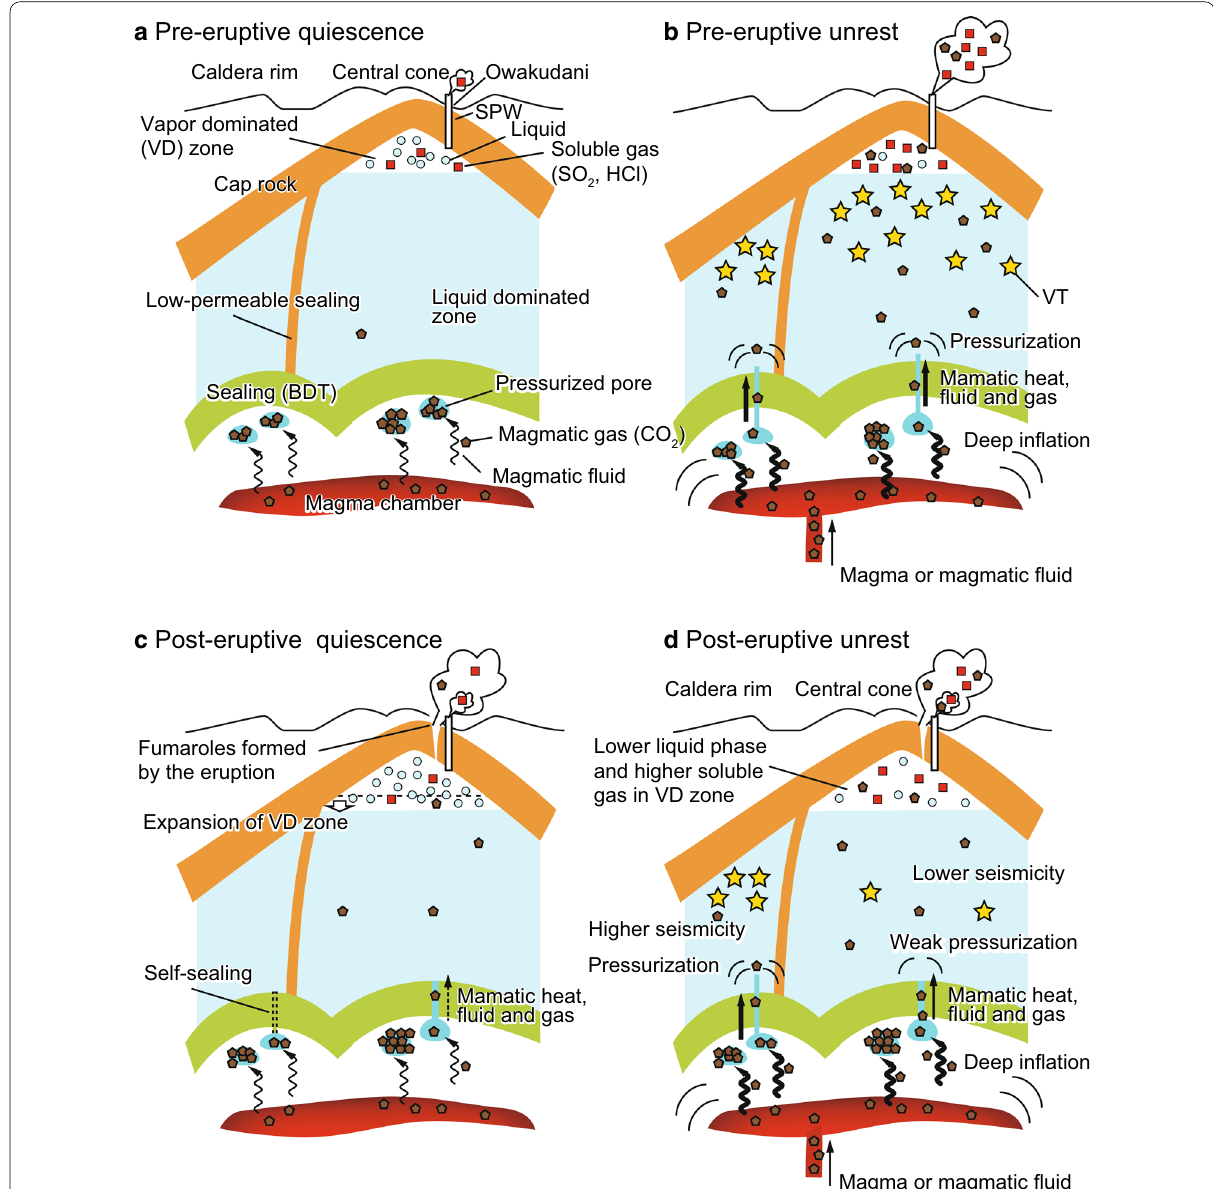
Fig. 12 Schematic model of the pre- and post-eruptive hydrothermal systems. Not drawn to scale. See text for depth and dimension of the features. a) Before the 2015 eruption, cap-rock and sealing at the brittle–ductile transition (BDT) were intact and magmatic gas accumulated within the pressurized pores beneath the BDT. We assume individual hydrothermal systems beneath the central cones and caldera rim are separated by a low-permeable sealing. b) Ruptures of sealing at the BDT induced by a deep inflation event allowed rapid migration of accumulated heat, fluid and pore pressure beneath the BDT to the liquid-dominated zones of the hydrothermal systems. Volcano-tectonic earthquakes (VTs) and steaming from the steam production wells (SPW) increased due to the pressurization of the hydrothermal system. c) The 2015 eruption formed paths for steam from the vapor-dominated (VD) zone to the surface. Due to the path, the post-eruptive hydrothermal system beneath the central cone was depressurized and volume of the VD zone increased. The rupture of seals at the BDT healed beneath the caldera rim, but were maintained beneath the central cones, which allows migration of heat and pore fluid beneath the BDT. d) Post-eruptive unrest episodes were also triggered by deep inflation event. Beneath the central cones, no extensive pressurization of the hydrothermal system occurs because pores beneath the BDT were not pressurized due to the rupturing in the 2015 eruption. Heat migration from deep to shallow lowered the liquid phase fraction within the VD zone and caused less effective scrubbing, which allowed enrichment of soluble gas (SO 2 and HCl) within the steams from the VD zone and fumaroles. Magmatic CO 2 within the fumaroles also rose, but not significantly due to no release of accumulated CO 2 within the pressurized pores beneath the